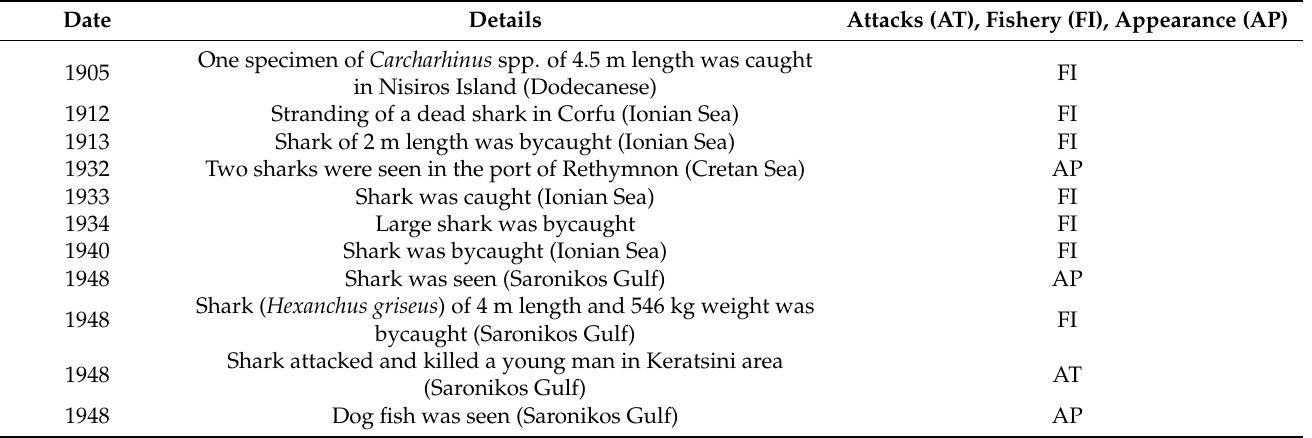
Table A1. References to shark sightings in the Greek Seas during